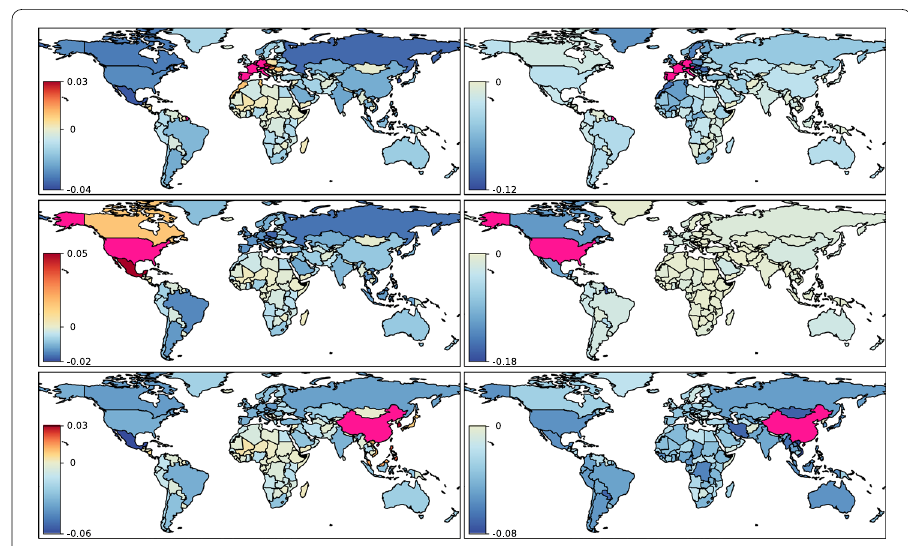
Fig. 5 Sensitivity of country balance. Sensitivity of country balance dB c / d δ cs for product price s = 7 (machinery) of KEU9 (top row), USA (middle row), China (bottom row). Left column: probabilities are computed from PageRank and CheiRank vectors. Right column: probabilities are computed from the trade volume of Export–Import. Data are shown for year 2018. Balance values are marked by color with the corresponding color bar ( j ). Sensitivity values for KEU9, USA, China are dB c / d δ cs = 0.12,0.12,0.15 (left column) and 0.21, 0.18, 0.24 (right column) respectively, these values are marked by separate magenta color to highlight sensitivity of other countries in a better way